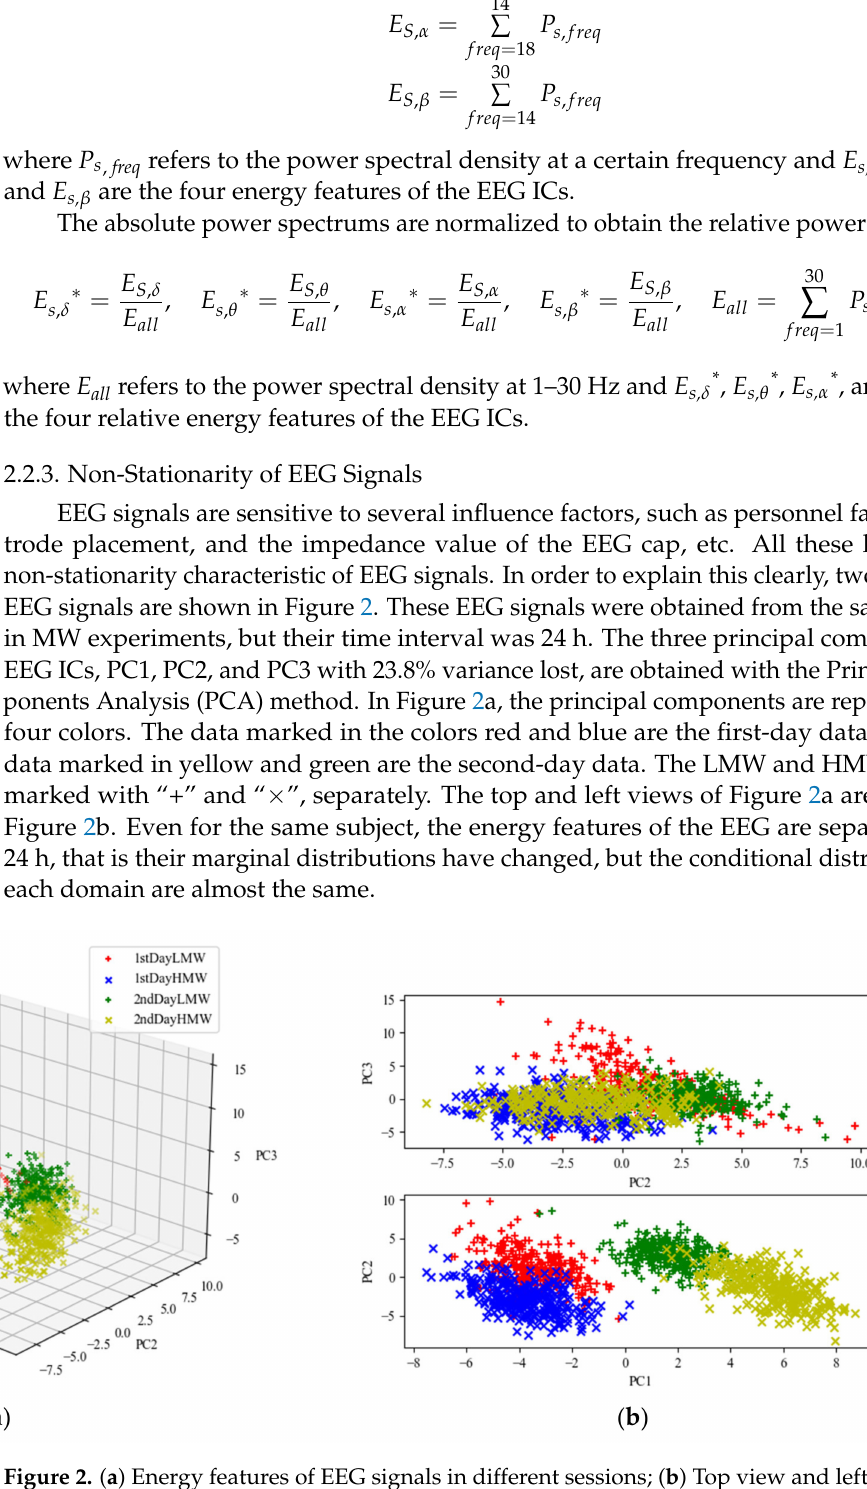
Figure 2. ( a ) Energy features of EEG signals in different sessions; ( b ) Top view and left view of the energy